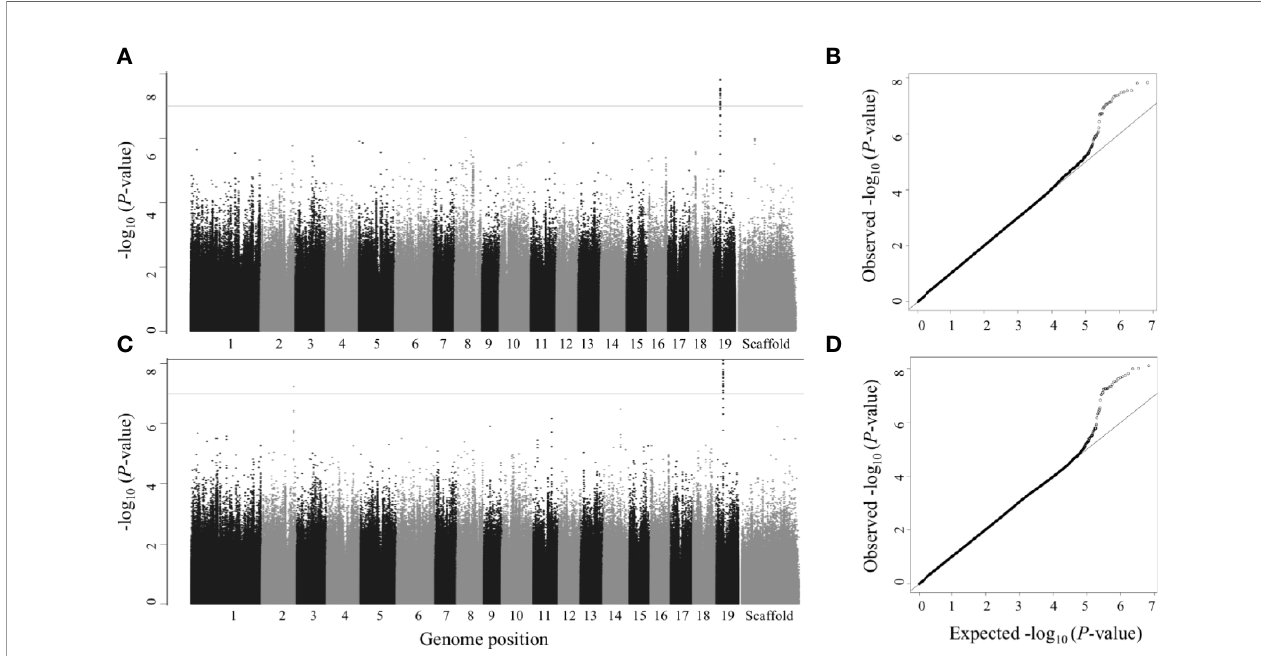
FIGURE 3 | Single trait GWAS – Manhattan (left) and QQ plots (right). Numbers 1 to 19 represent chromosomes; scaffolds are the reads that did not align to any of the 19 chromosomes. (A , B) Leaf dry weight; (C , D) Leaf wet weight. SNPs above gray line have p <1×10 -7 , which is roughly equivalent to FDR ≤ 0.1 and SNPs above black line (the top line) have p <7.417×10 -9 (the Bonferroni correction threshold), which is roughly equivalent to FDR ≤ 0.05 in this